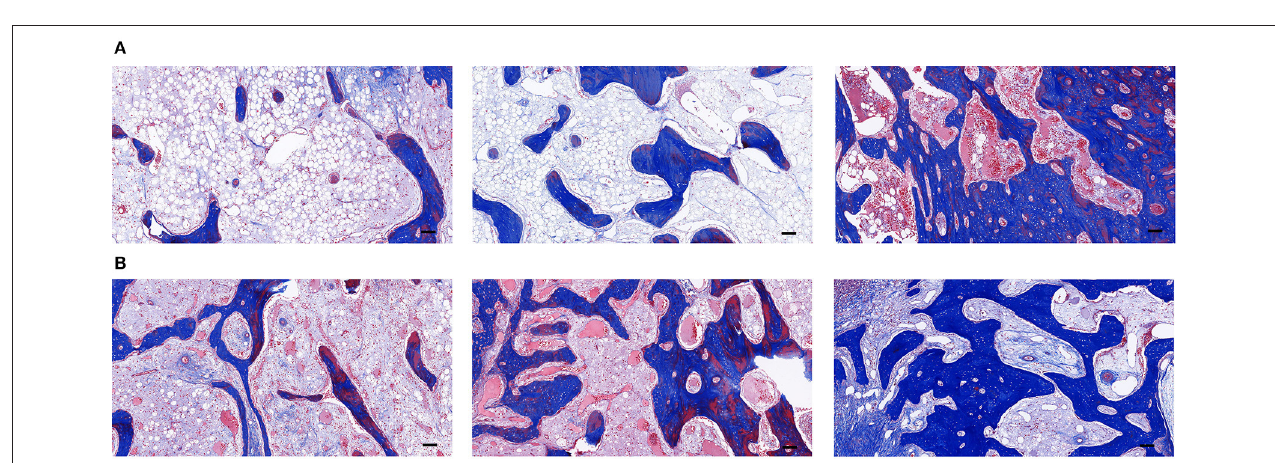
FIGURE 7 | (A) The H&E staining of the distraction osteogenesis (DO) region of the mandible in the blank control (group A), the green fluorescent protein (GFP) (group B), and the bone morphogenetic protein 1 (BMP-1) (group C) at 3 weeks of fixation (Scale: 100 µ m). (B) The H&E staining of the distraction osteogenesis (DO) region of the mandible in the blank control (group A), the green fluorescent protein (GFP) (group B), and the bone morphogenetic protein 1 (BMP-1) (group C) at six weeks of fixation (Scale: 100 µ m).